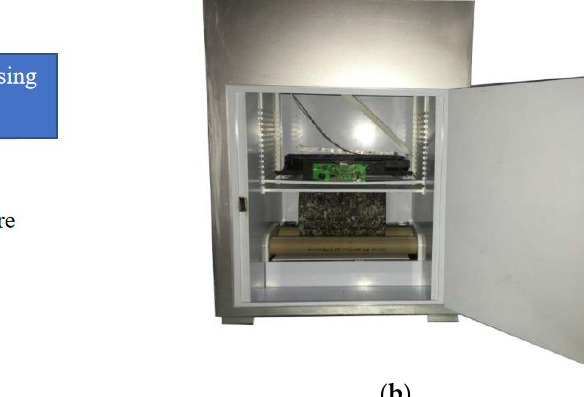
Figure 2. Asphalt mixture image system: ( a ) instrument components and working principle; ( b ) equipment setup.